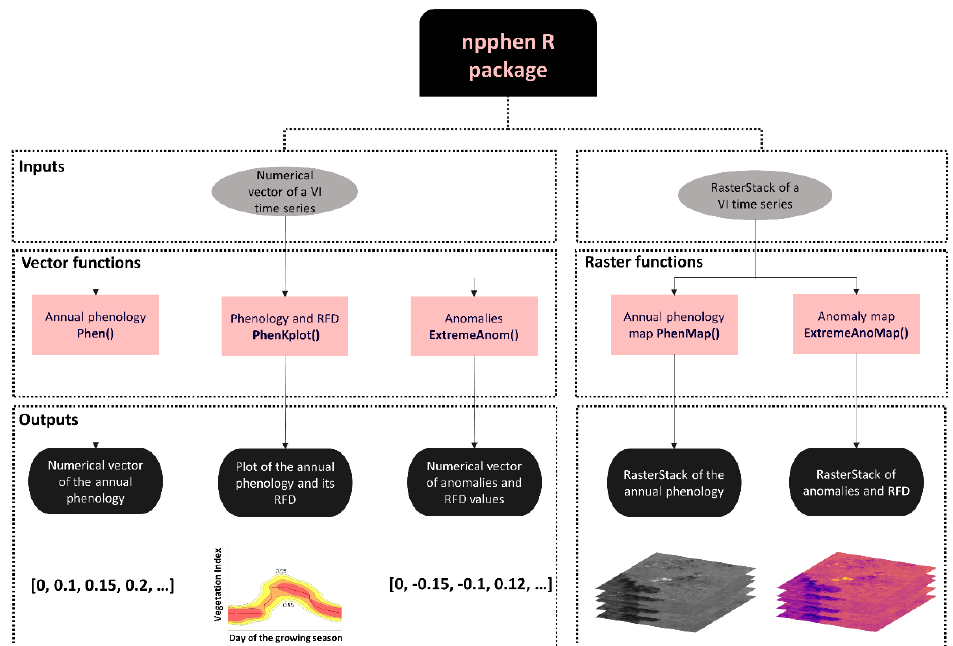
Figure 1. Inputs, functions and outputs for the “npphen” R package. Both phenology functions and anomaly functions can use either numerical vectors or raster stacks as inputs. Consequently, the outputs are numerical vectors or raster stacks, except for the PhenKplot function whose output is a graph of the reference phenology along with its historical variability.